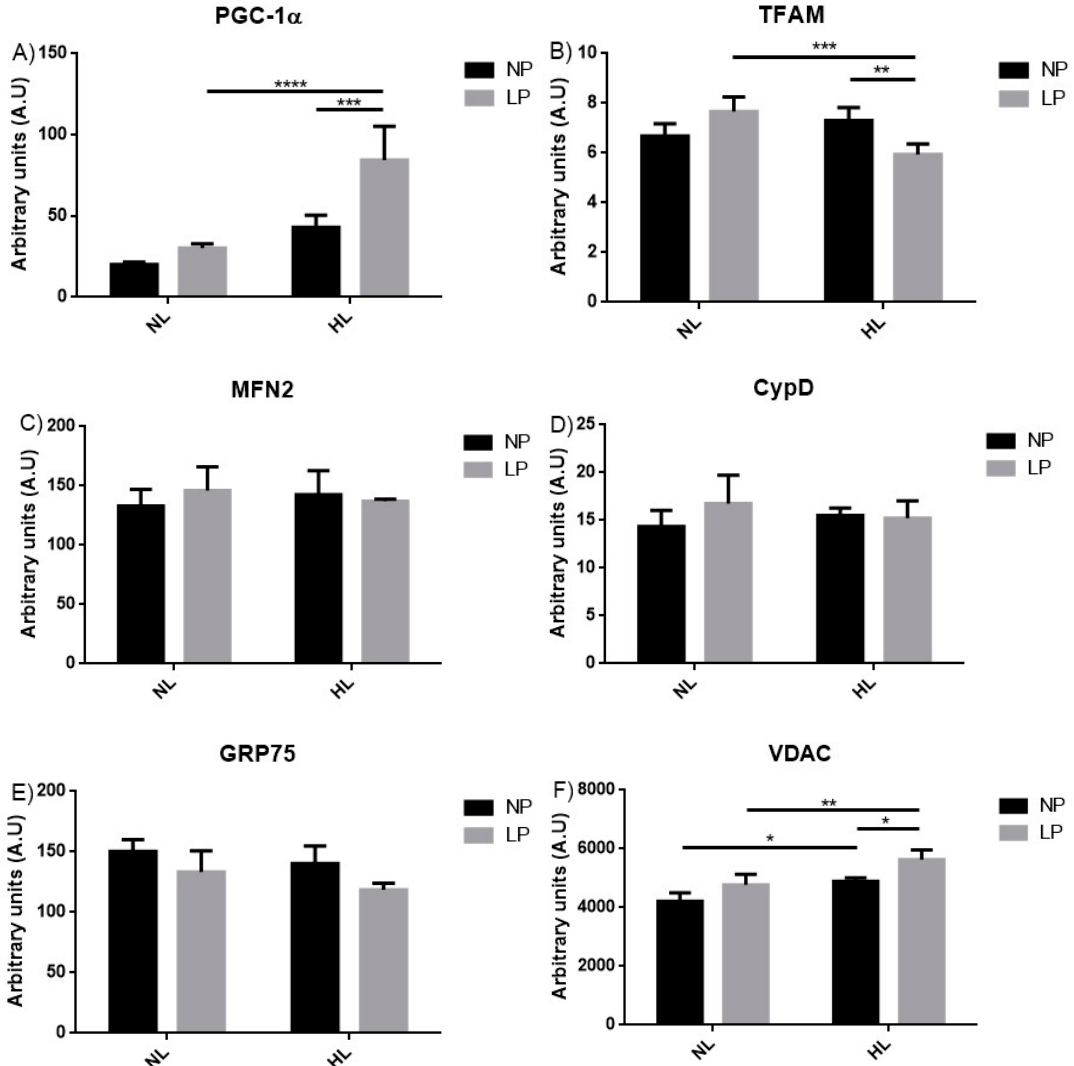
Figure 5. Evaluation of liver gene expression of adult rats subjected to the low protein diets during gestation and lactation and post-weaning hyperlipidic diet. Genic expression of ( A ) Peroxisome proliferator-activated receptor gamma, coactivator 1 alpha (PGC-1 α ), ( B ) transcription factor A, mitochondrial (Tfam), ( C ) Mitofusin 2 (MFN2), ( D ) Cyclophilin D (CypD), ( E ) glucose-regulated protein 75 (GRP75), and ( F ) voltage-dependent anion channel 1 (VDAC) in liver of 90-day-old male rats born to mothers fed a normoprotein (NP) or low protein (LP), during gestation and lactation, and normolipidic (NL) or hyperlipidic diets (HL) after weaning up to adulthood. All values were expressed as mean ± SEM. * p < 0.05; ** p < 0,01; *** p <0.001; **** p < 0.0001, performed with two-way ANOVA followed by the Bonferroni multiple comparison test.